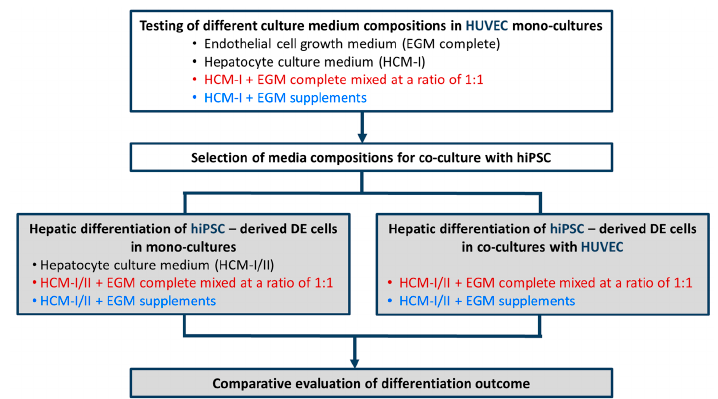
Figure 1. Schematic outline of experimental procedures for media testing in mono-cultures of human umbilical vein endothelial cells (HUVEC, white boxes) and for hepatic differentiation of hiPSC-derived definitive endodermal (DE) cells with or without HUVEC (grey boxes). Different mixtures of hepatocyte culture medium (HCM) and endothelial cell growth medium (EGM) were tested. Colors used for the different media compositions correspond to those used in the graphs.